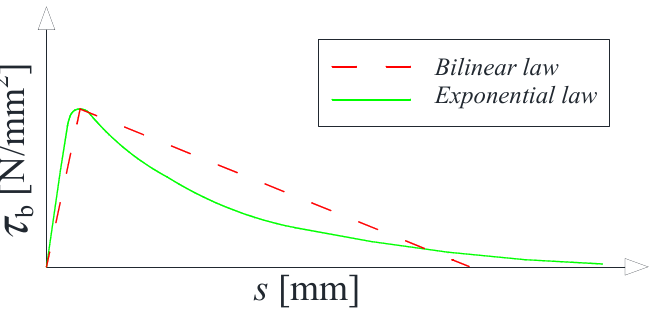
Figure 6. Interface laws.